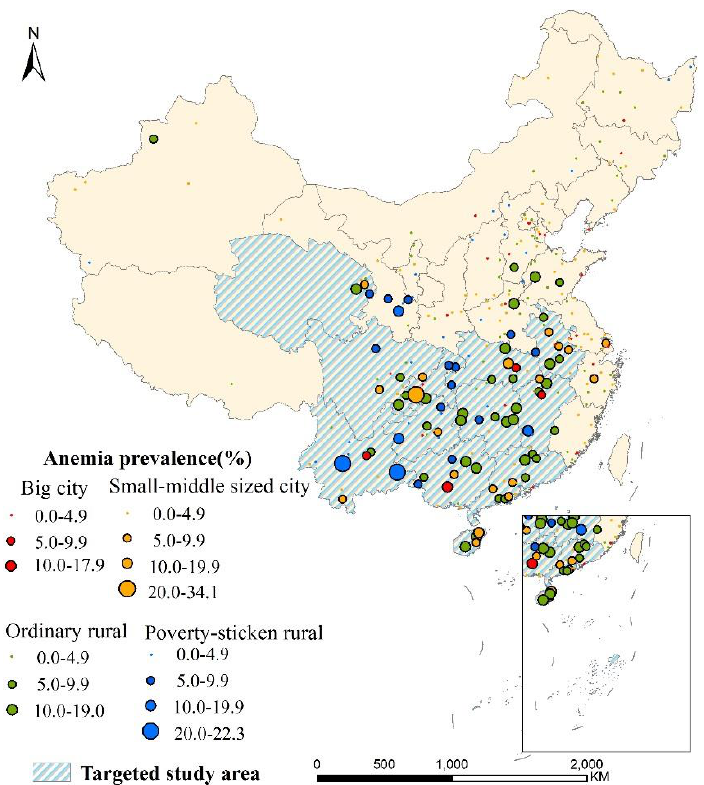
Figure 3. Anemia prevalence of SAC in primary schools at surveillance points.